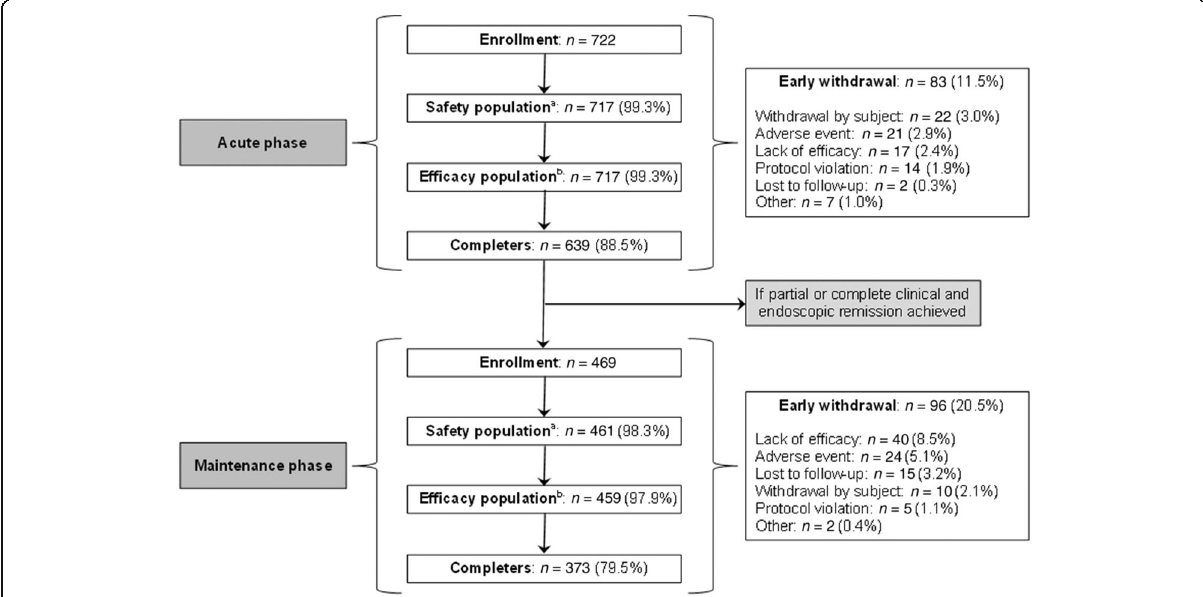
Fig. 1 Flow chart for disposition of trial patients. a The safety population within each phase was defined as all patients who took at least one dose of the investigational product during that phase. b The efficacy population within each phase was defined as all patients who took at least one dose of the investigational product and had at least one post-dose efficacy assessment during that